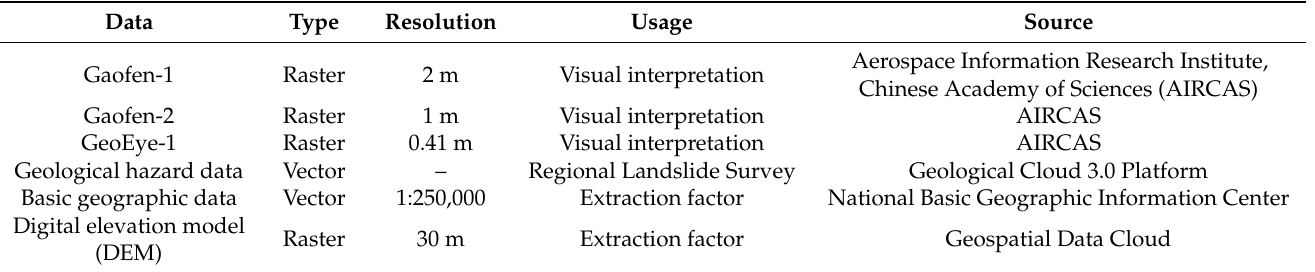
Table 1. Landslide susceptibility mapping data.